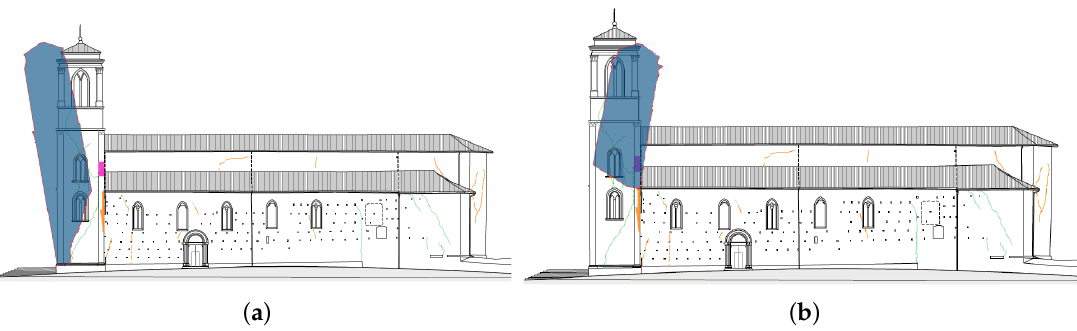
Figure 14. Observed collapse mechanism of the St.Silvestro belfry: ( a ) The first overturning; ( b ) The second overturning.